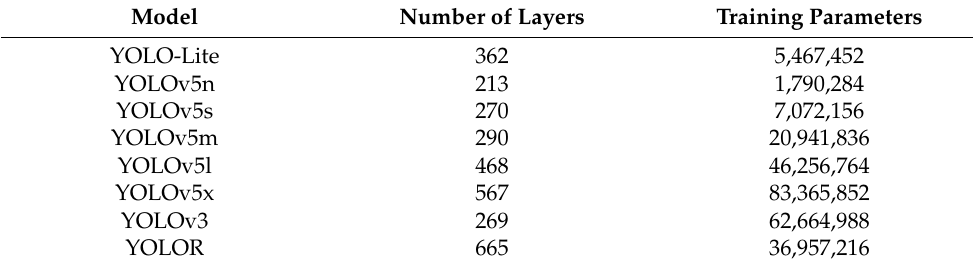
Table 3. Information of model variation used in training.